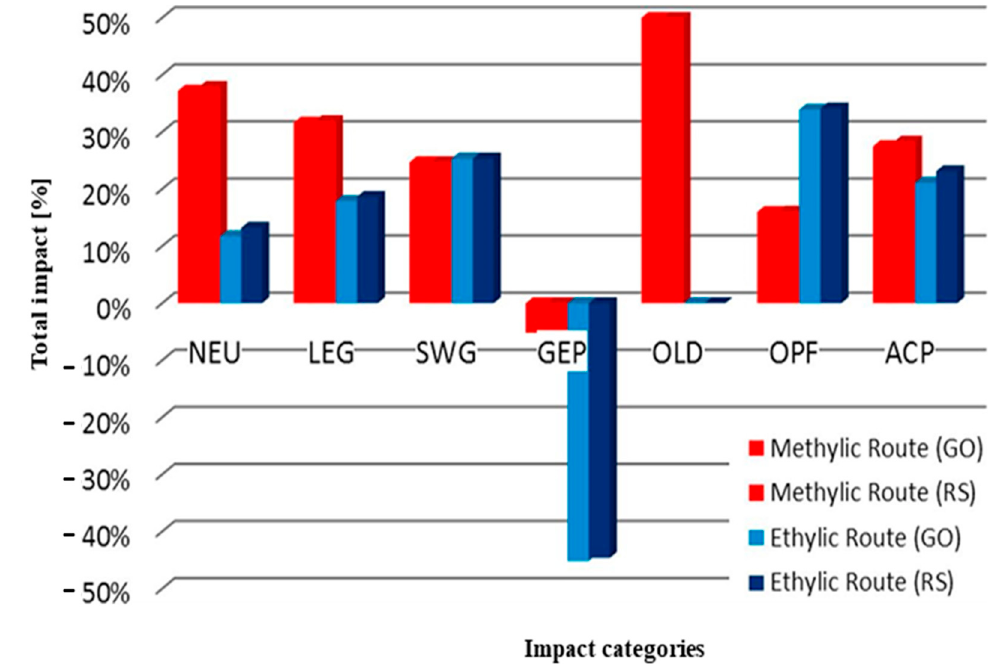
Figure 4. Comparative environmental impact analysis of the soybean biodiesel production by two different technologies: the alkali-catalyzed methylic transesterification and the enzyme-catalyzed ethylic transesterification for two different localizations, where NEU is non-renewable energy usage, LEG—liquid effluents’ generation, SWG—solid waste generation, GEP—the greenhouse effect potential, OLD—the potential of ozone layer depletion, OPF—the potential of ozone photochemical formation, and ACP—the acidification potential [75].